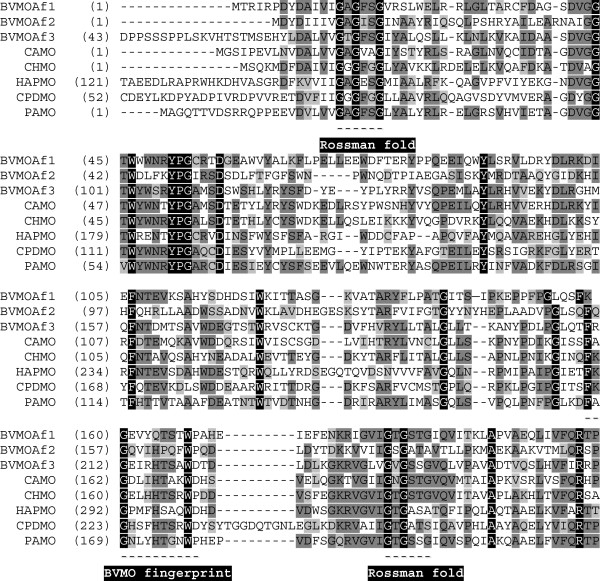
Multiple sequence alignment of some BVMOs sequences. Sequences are: BVMOAf1 (XP_747160), BVMOAf2 (XP_746949) and BVMOAf3 (XP_755274) from A. fumigatus Af293, PAMO (YP_289549) from Thermobifida fusca, CHMO (AAG10021) from Acinetobacter sp., HAPMO (AAK54073) from Pseudomonas fluorescens, CPDMO (BAE93346) from Pseudomonas sp. HI70 and CAMO (AET80001.1) from Cylindrocarpon radicicola. The two Rossmann folds (GxGxxG) and the BVMO fingerprint (FxGxxxHxxxWP/D) are highlighted.